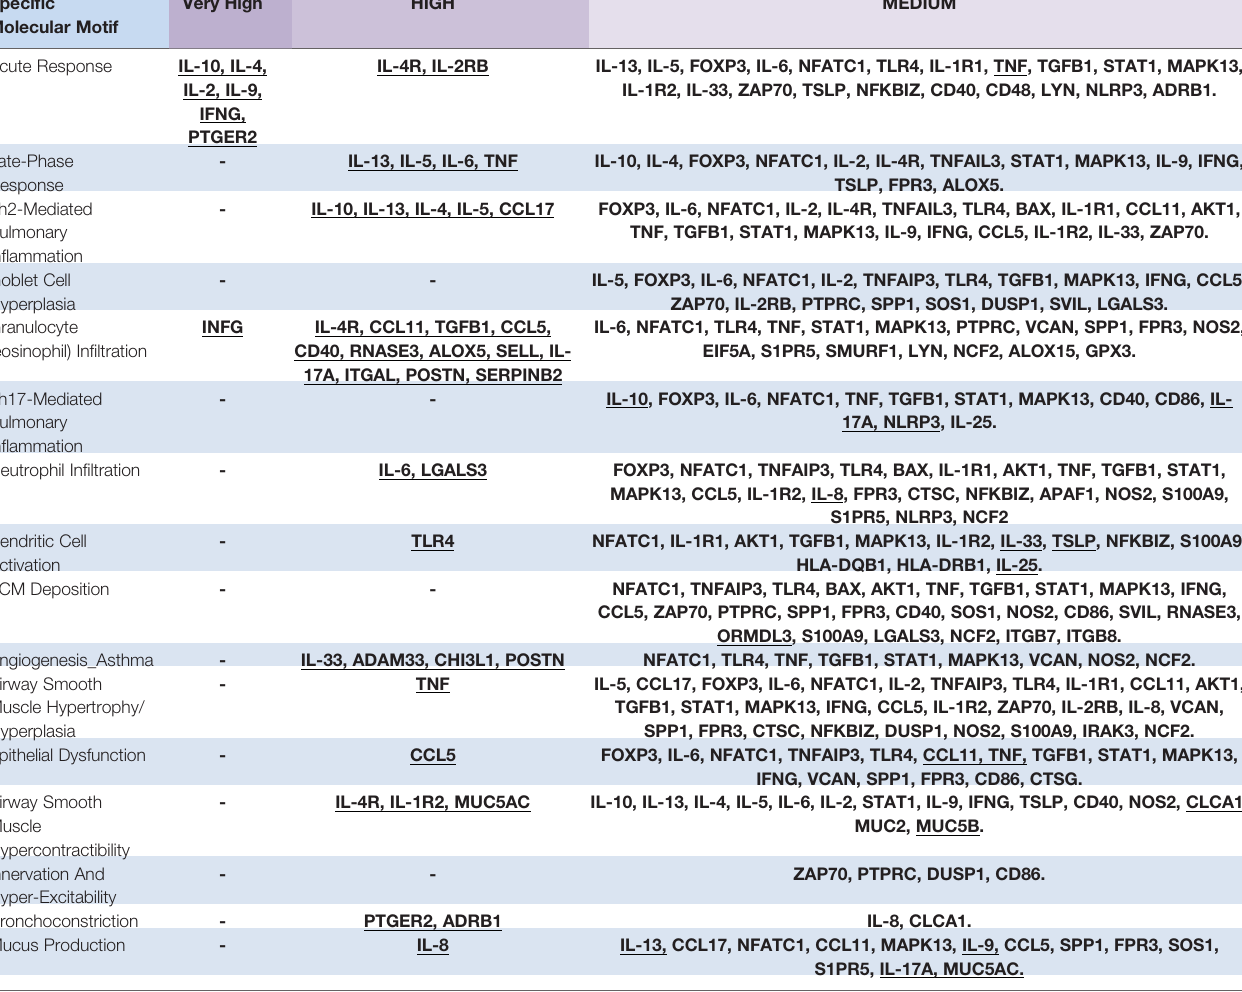
TABLE 4 | Ranking of Proteins classi fi ed by association with molecular motifs (Effectors proteins are underlined). Speci fi c Molecular